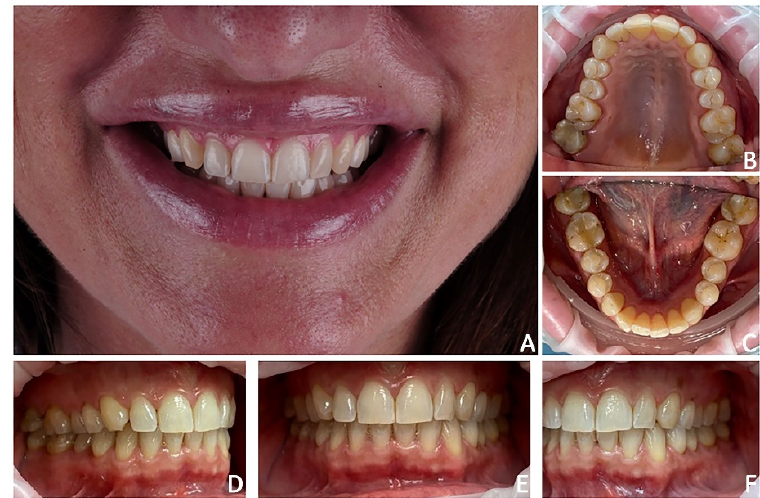
Figure 1. Case 1. Pre-treatment patient characteristics: ( A ) extra-oral smile view; ( B ) intra-oral upper occlusal view; ( C ) intra-oral lower occlusal view; ( D ) intra-oral lateral right view; ( E ) intra-oral frontal view; ( F ) intra-oral lateral left view.